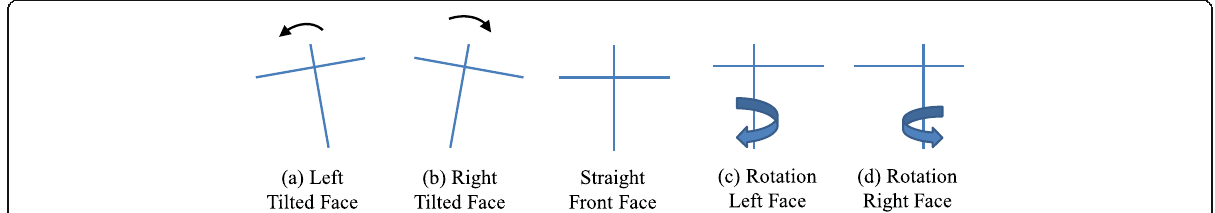
Fig. 8 Four major deformations based on detected cross in face images. a Left-tilted face. b Right-tilted face. c Rotation left face. d Rotation right face